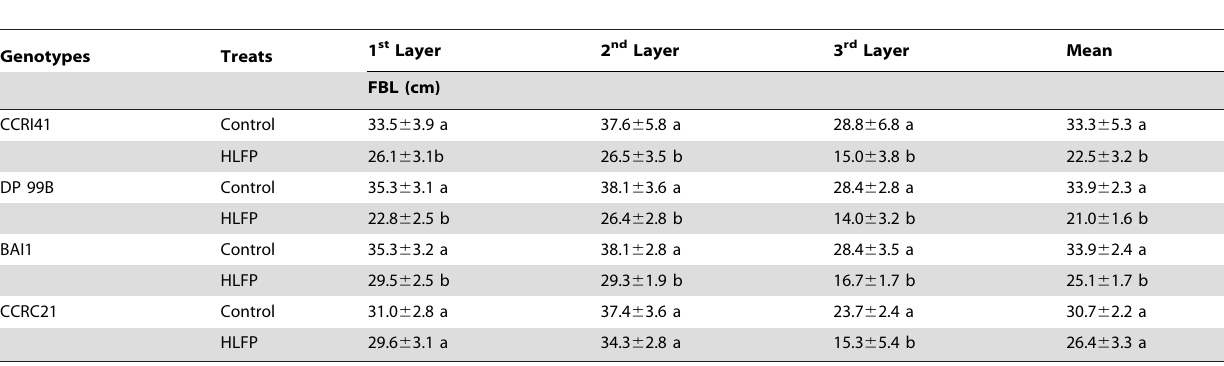
Table 2. Effects of mechanical stress caused by hanging labels from the petioles (HLFP) of every white flower in the field on the fruiting branch lengths (FBL values) for four cotton genotypes.